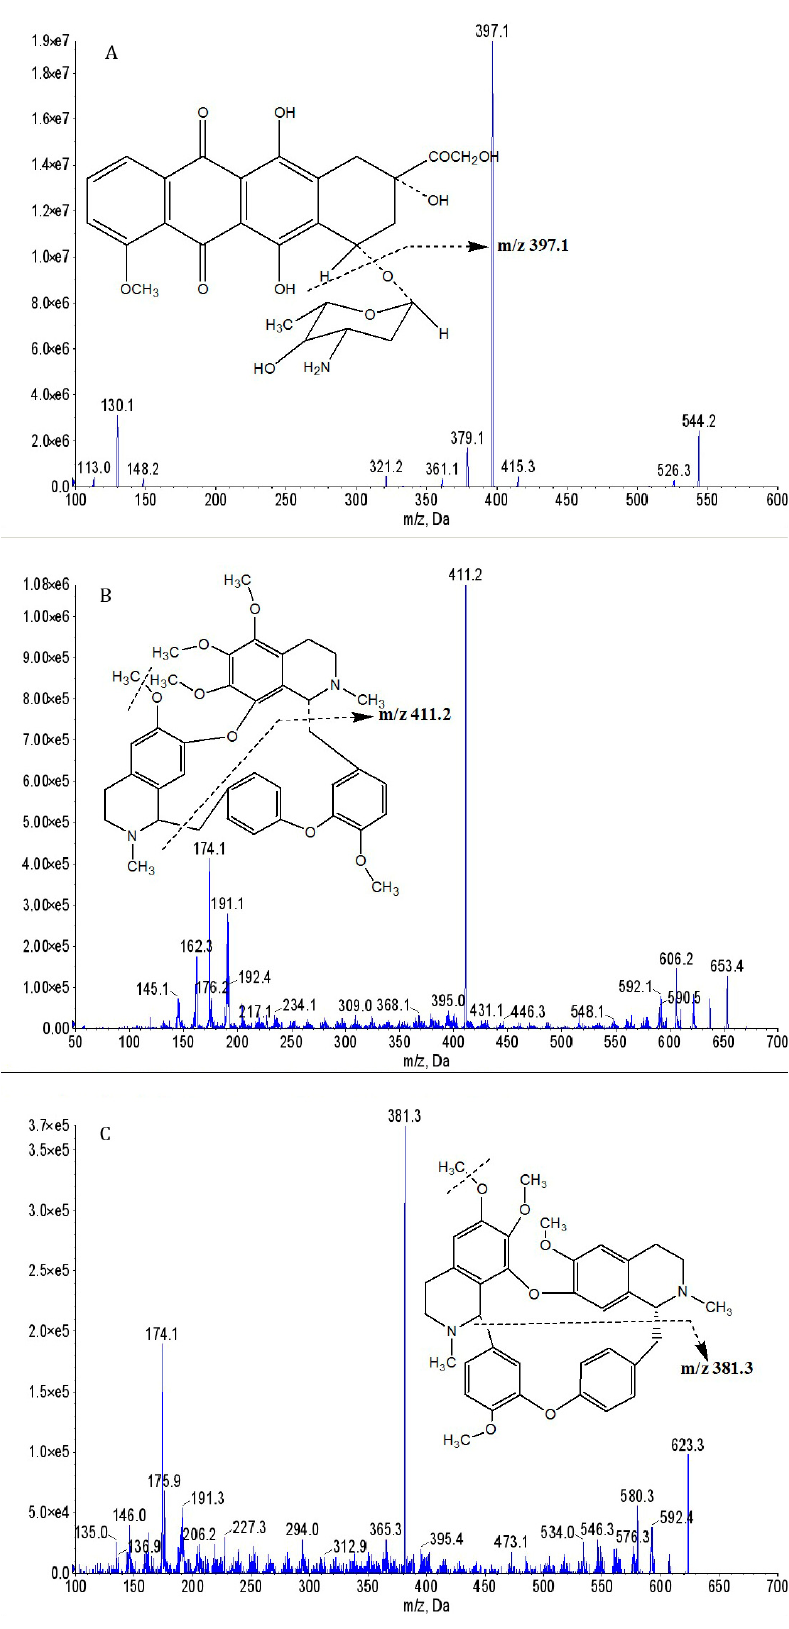
Figure1. Representative MSof( A )doxorubicin(DOX),( B )hernandezine(HER), and( C